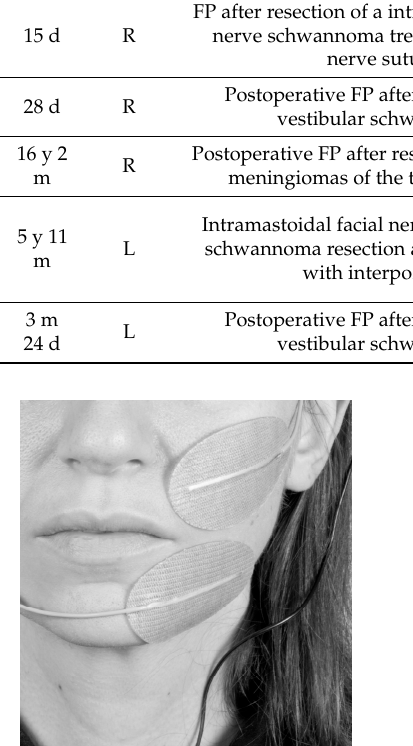
Figure 1. Example of how the electrode placement was conducted during the study (from the patient’s diary specifically generated for the study).